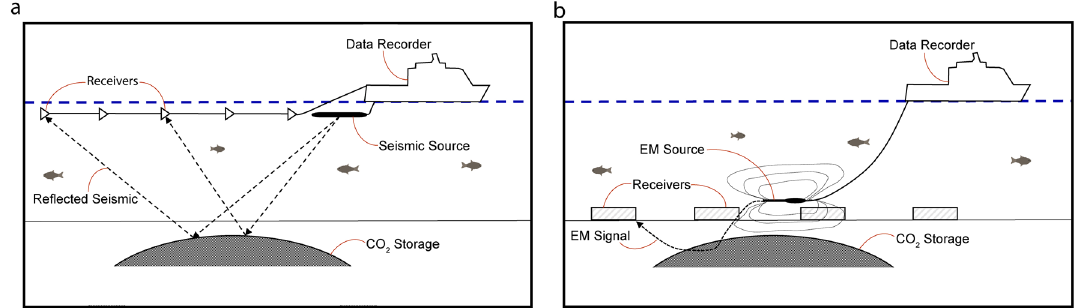
Figure 1. ( a ) Seismic and ( b ) electromagnetic acquisition methods in the case of marine